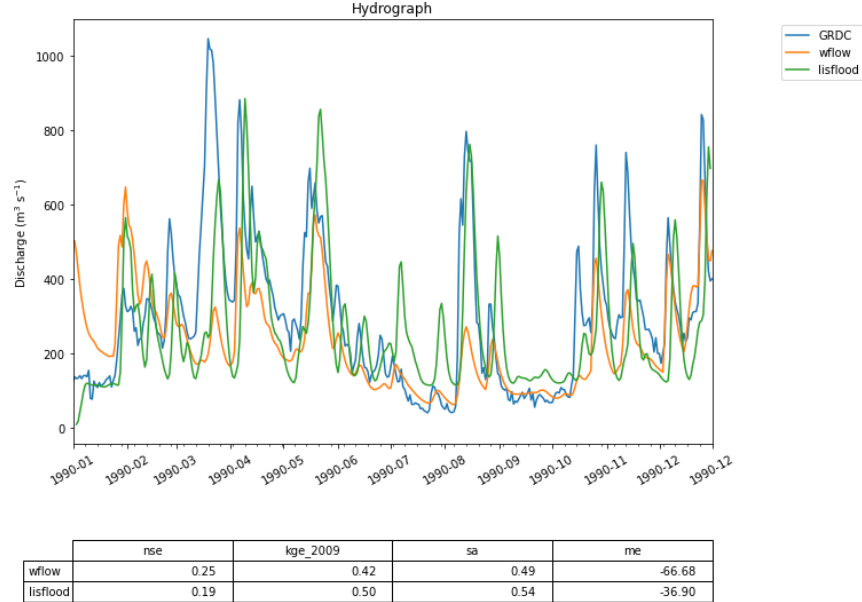
Figure 7. Two hydrographs generated by the Wflow and the LISFLOOD models compared to GRDC observations for the Merrimack basin. While the code used to run these two models given in Fig. 8 is similar to that in the first use case, the models are far more complex and generate better predictions of streamflow.